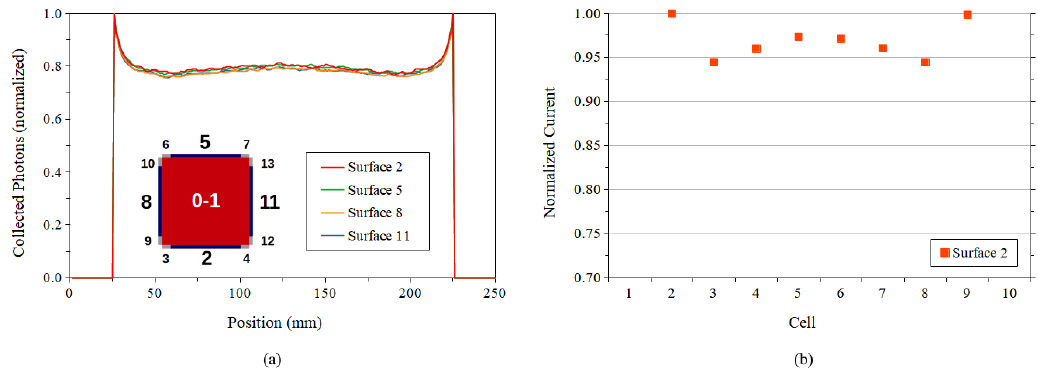
Figure 7. Unshaded LSC panel with four 8-cells PV arrays: ( a ) Normalized number of rays of light collected by the PV cells as a function of the position along the LSC side, which ranges from 0 mm to 250 mm. ( b ) Normalized current produced by each PV cell.